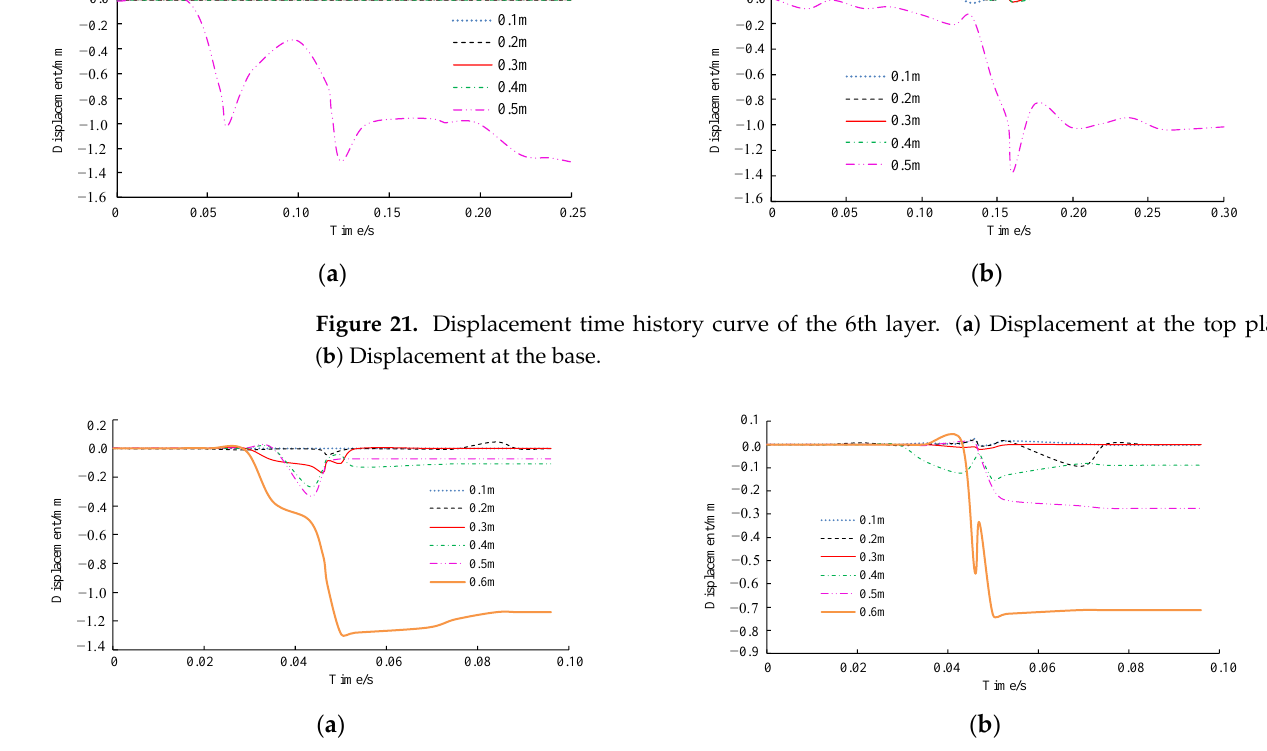
Figure 22. Displacement time history curve of the 7th layer. ( a ) Displacement at the top plate; ( b ) Displacement at the base.